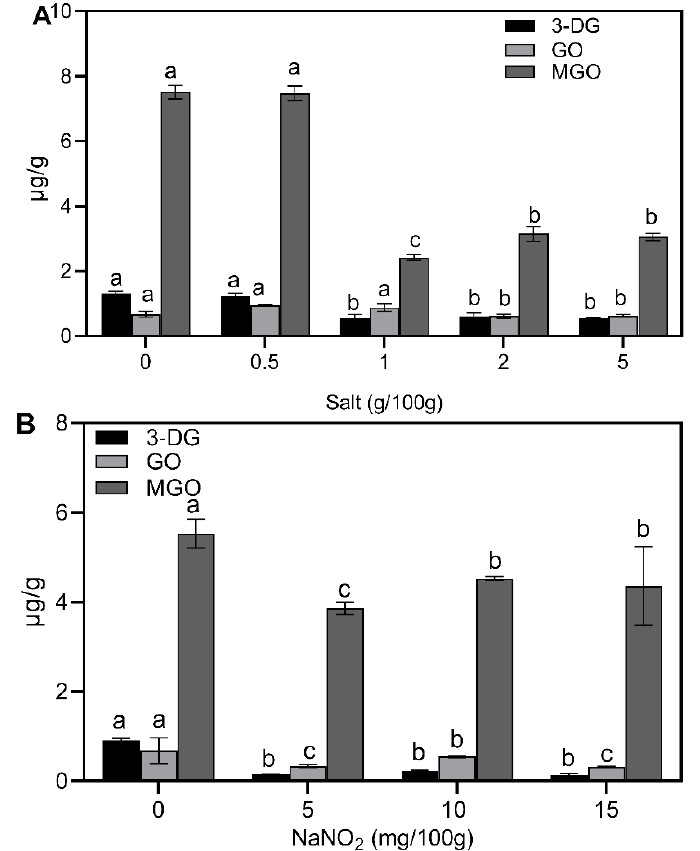
Figure 5. Effect of additive on α -dicarbonyl compounds: ( A ) salt; ( B ) nitrite. Different letters above the bars indicate significant differences (n = 3, p < 0.05). Methylglyoxal (MGO), glyoxal (GO) and 3-deoxyglucuronide (3-DG).